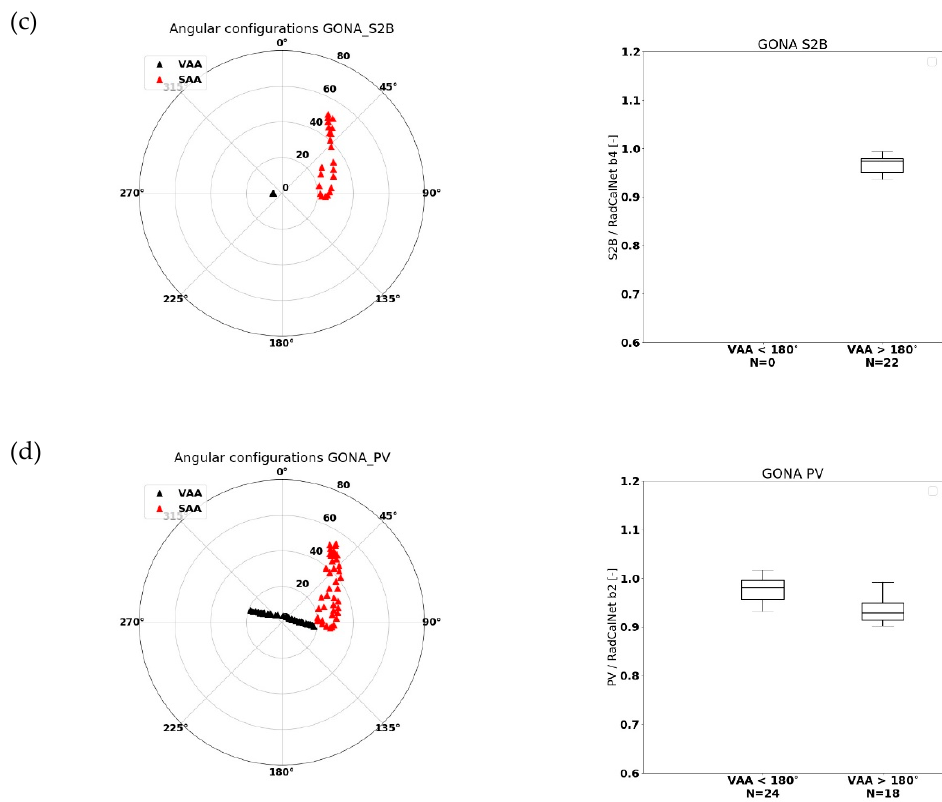
Figure 4. (left) Observation and illumination geometries for LS8 ( a ), S2A ( b ), S2B ( c ), and PROBA-V ( d ) over GONA. The viewing zenith and viewing azimuth angles (VZA and VAA) are represented by black triangles, while the solar zenith and solar azimuth angles (SZA and SAA) are denoted by red triangles. Zenith angles are plotted along the circle’s radians and increase from the center going outwards. Azimuth angles start at 0 ◦ (North), increasing clockwise. (right) Box-whisker plots for the RED channel of the observed / Radcalnet-simulated TOA reflectance ratios over GONA. Results are divided into classes with VAA < 180 ◦ and VAA > 180 ◦ . The horizontal line represents the median value, whereas the lower and upper box boundaries denote the 25th and 75th percentiles, respectively. Lower and upper whiskers represent the 5th and 95th percentiles, respectively.